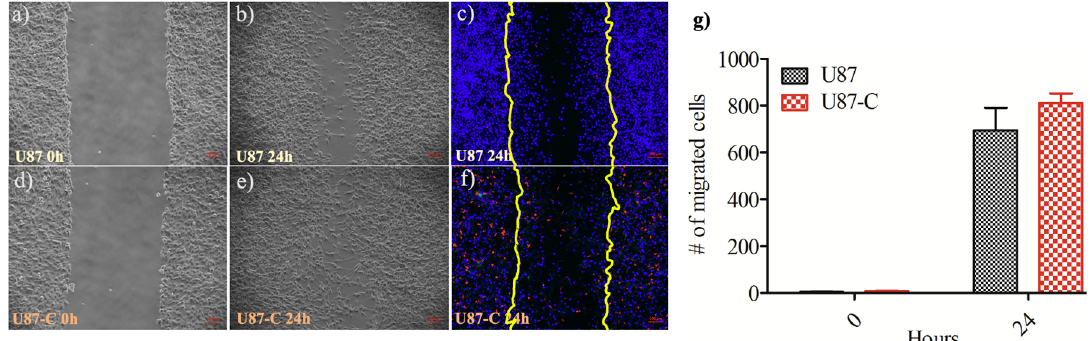
Figure 3. Analysis of U87 and U-7-C cells migration by the in vitro wound-healing assay. The phase images of U87 cells when the ( a ) wound created at 0 h, ( b ) phase images of wound closure at 24 h, ( c ) fluorescence images of wound closure at 24 h, the nucleus of the cells are labeled with DAPI and displayed in blue, dead cells are PI-stained and shown in red, yellow lines present the wound area created at 0 h. The same settings were applied for U87-C ( d – f ). The images acquired with 10 × magnification; the scale bar shows 100 µ m. ( g ) The number of migrated cells at 0 and 24 h. The results represent the mean ± standard deviation of two independent experiments. There was no significant difference according to the Student’s unpaired, two-tailed t-test, p = 0.9051.